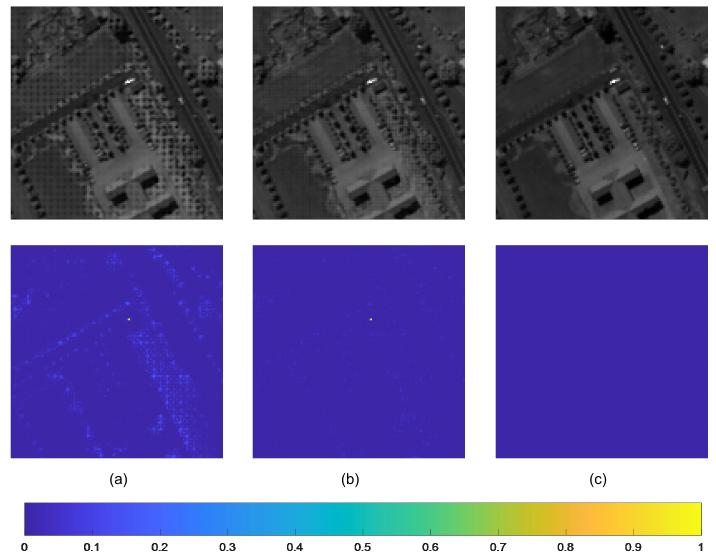
Figure 5. Reconstructed HR-HSI and its corresponding error image at the 63rd band for Pavia